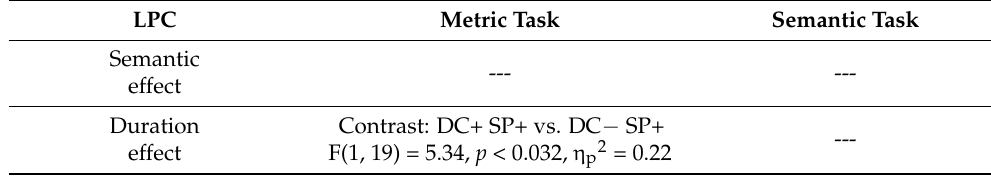
Table 5. F and p values from Task, Duration and Semantic interaction for the late window. LPC Metric Task Semantic Task Semantic --- --- effect Duration Contrast: DC+ SP+ vs. DC − SP+ effect